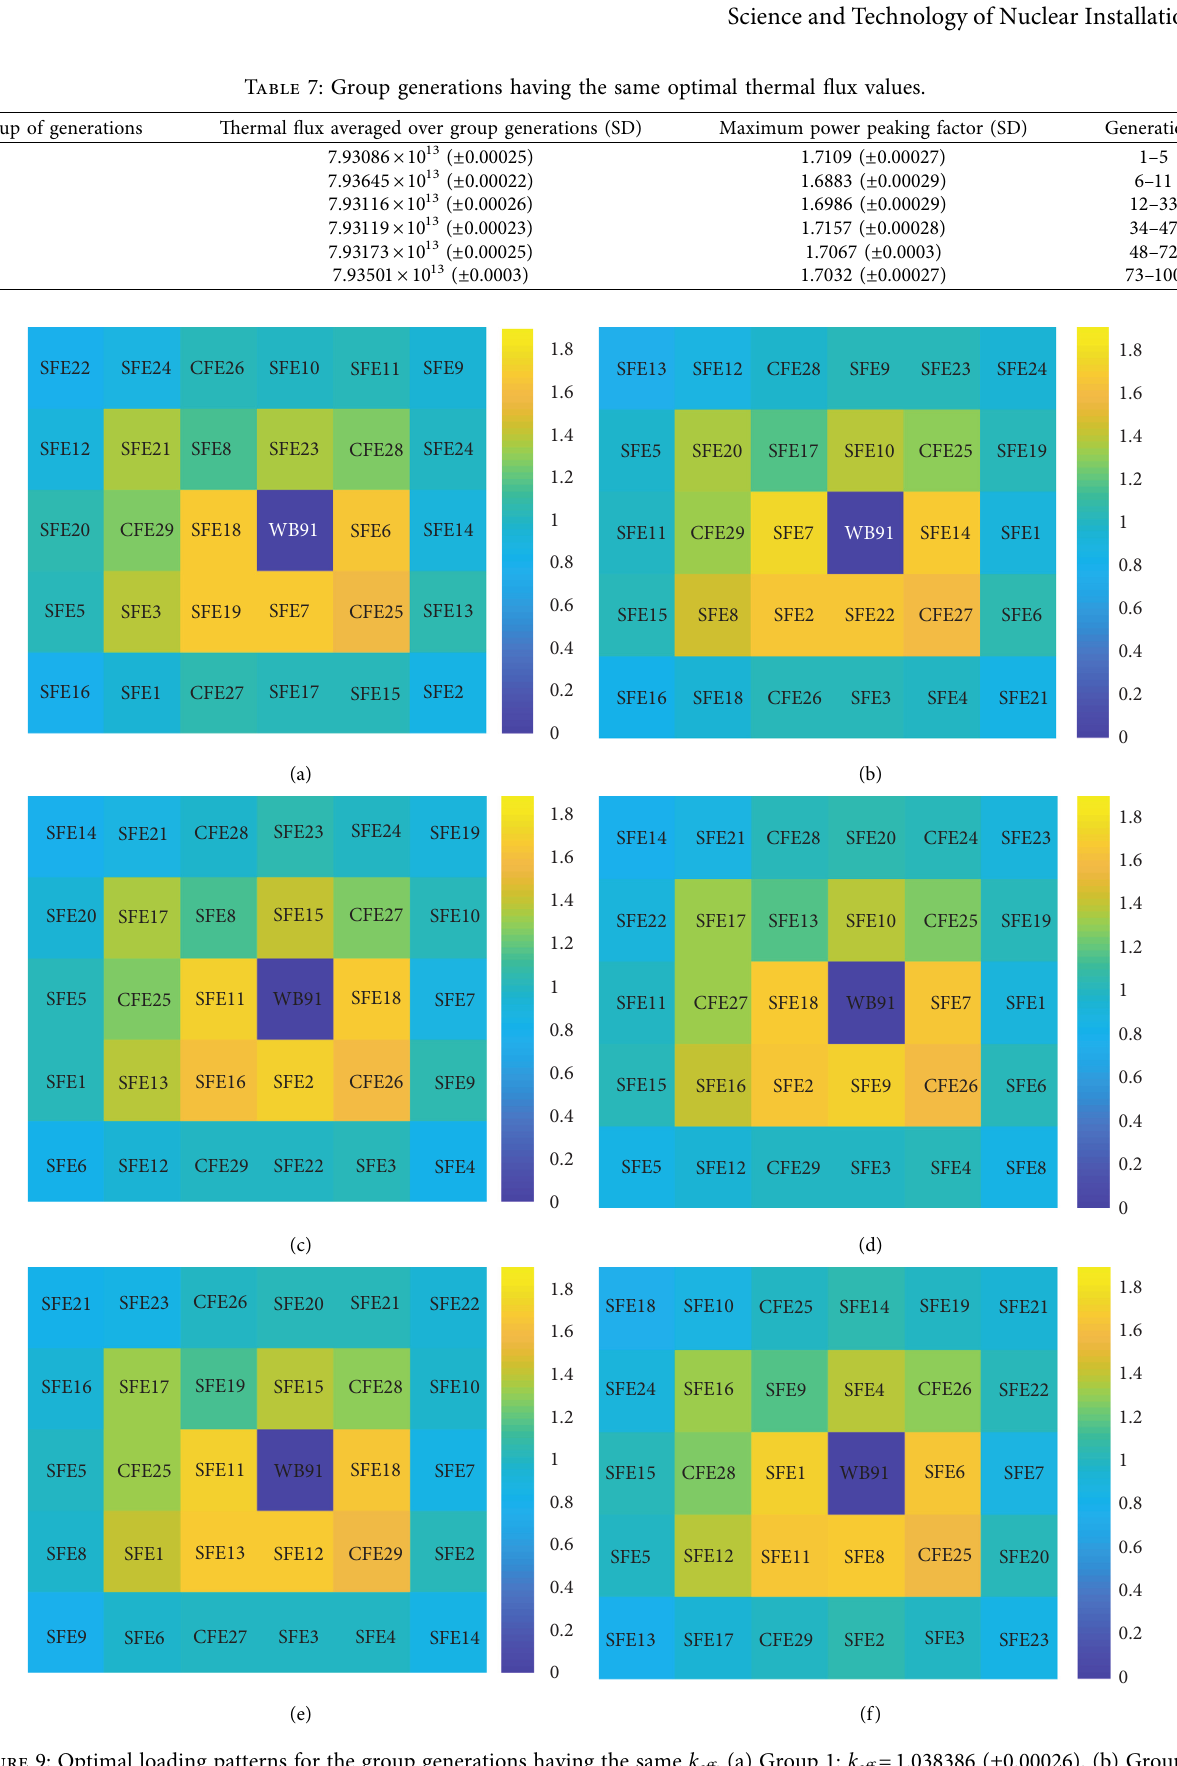
� 1.038386 ( ± 0.00026). (b) Group 2: eff . (a) Group 1: k eff